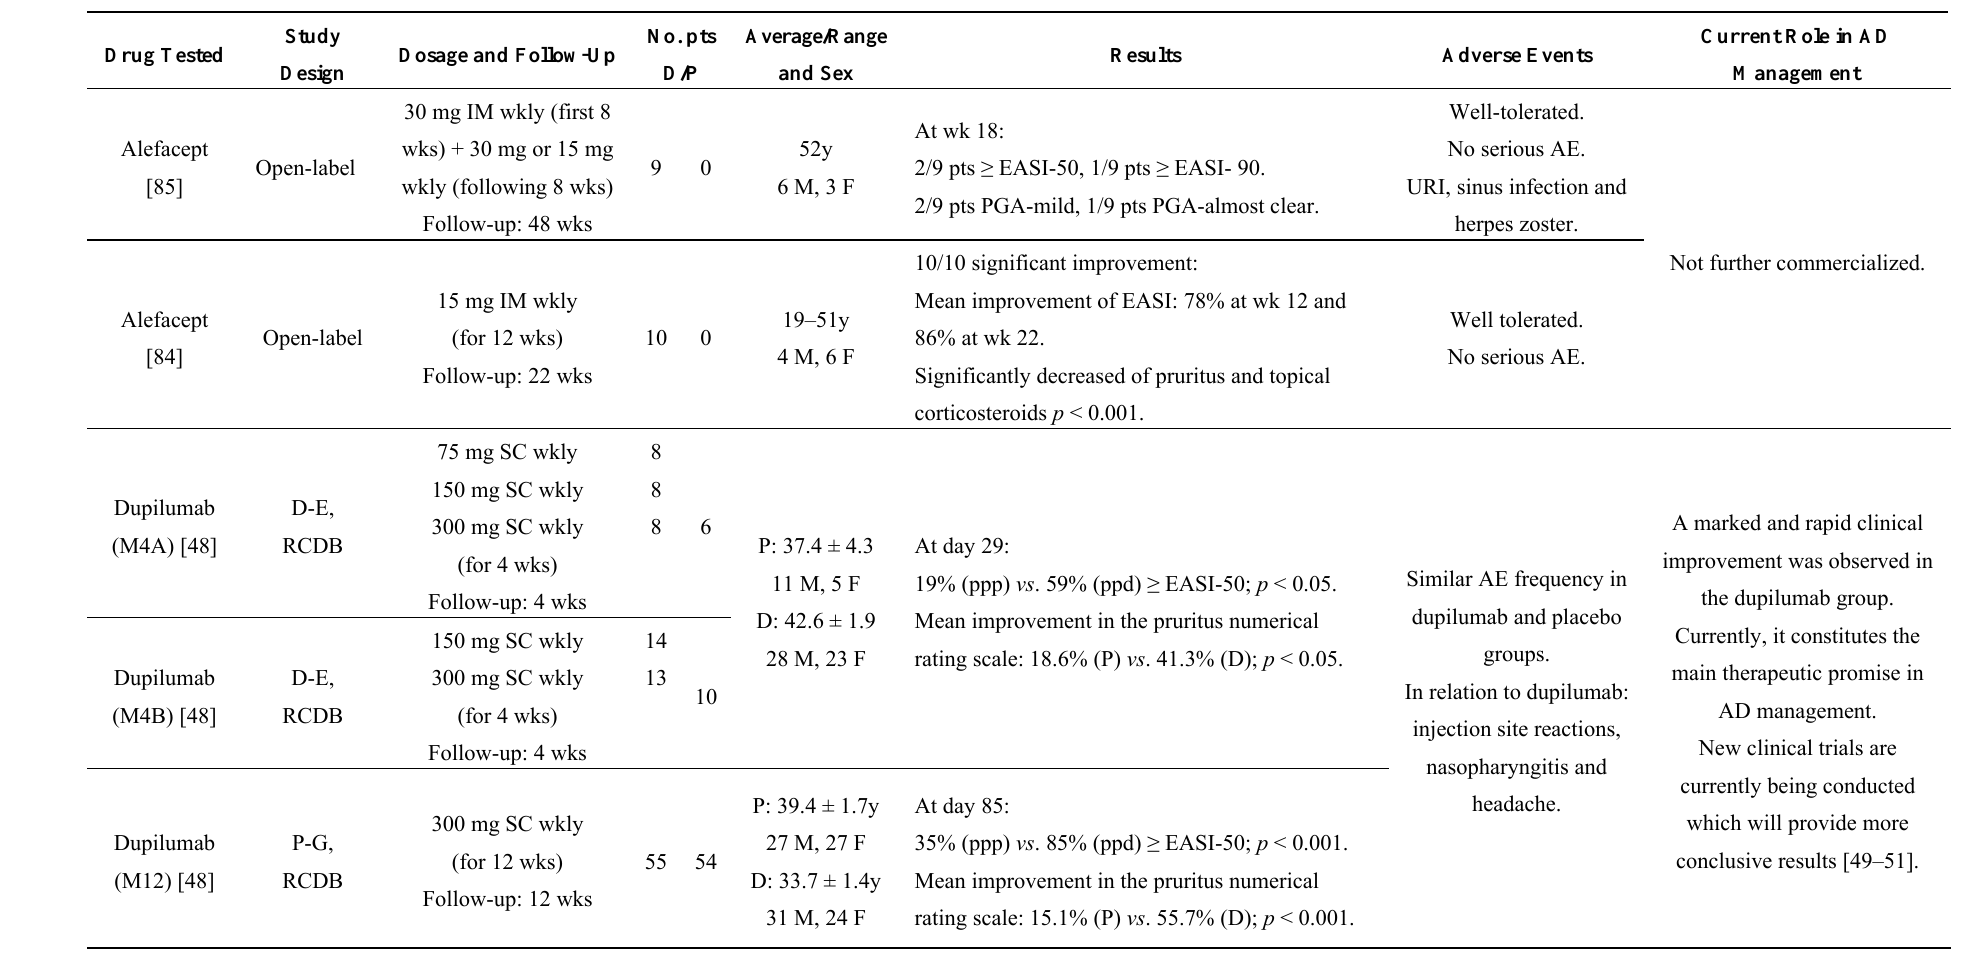
Table 1. Characteristics of three-or-more-patient studies included in the systematic